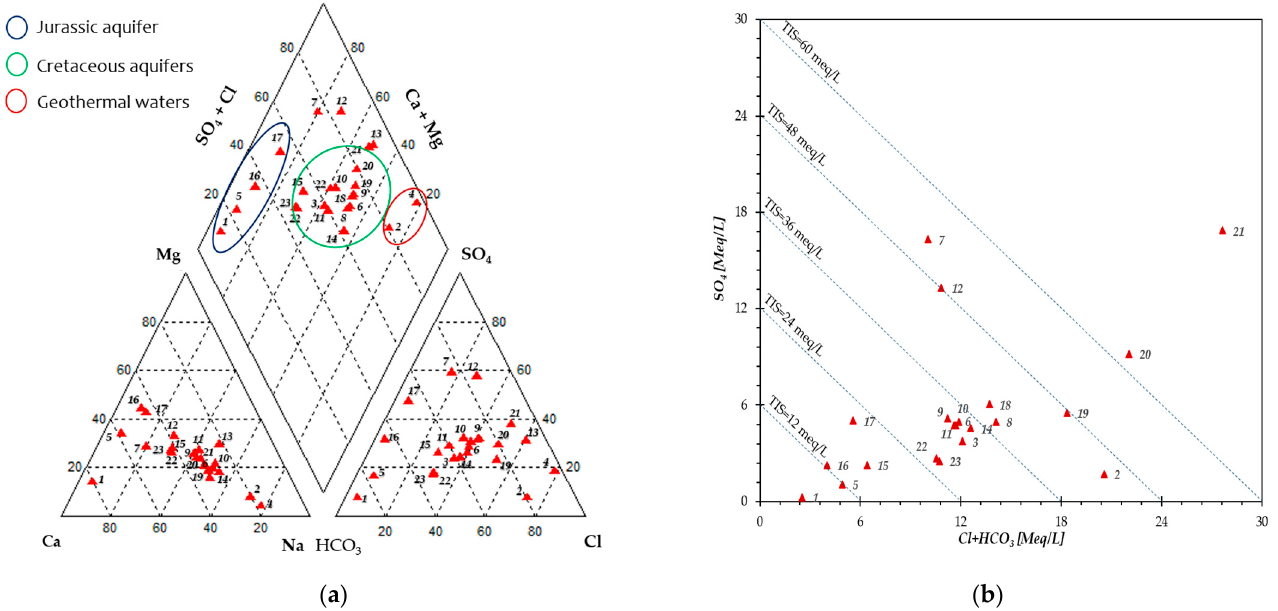
Figure 3. ( a ) Piper diagram and ( b ) SO 4 vs. Cl + HCO 3 (TIS) plot reporting the samples collected in the study area. In the TIS diagram, the isoionic salinity lines are drawn as reference.